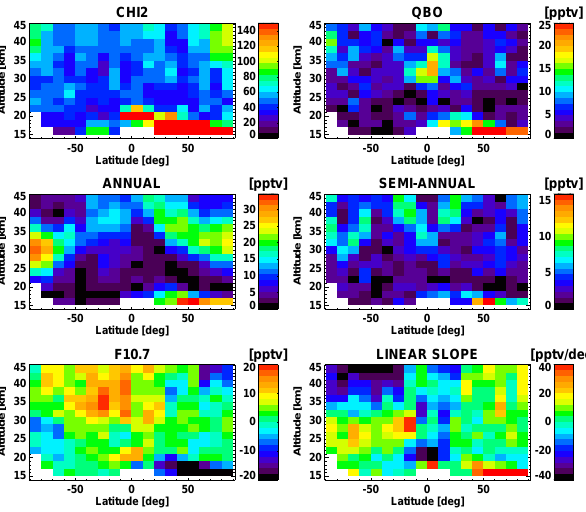
Fig. 15. Global overview of the fit RMS (top left), the amplitudes of various fit parameters and the linear trends (bottom right). For “QBO” and “ F 10 . 7 ”, the amplitude is defined as the semi-difference between maximum and minimum of the fitted time series of Singa- pore winds and solar F 10 . 7 flux, respectively. For “ F 10 . 7 ” the sign indicates a positive or negative correlation with the solar cycle.